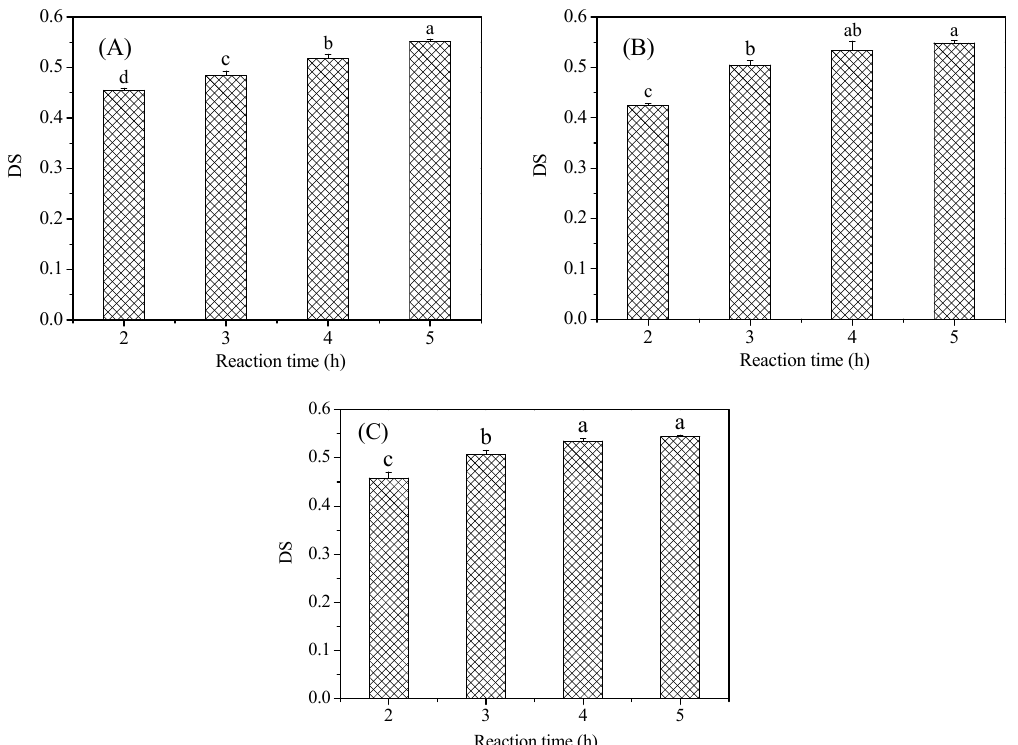
Figure 1. DS (degree of substitution) of malate starch samples: ( A ) Corn starch, ( B ) Potato starch, ( C ) Pea starch. Different letters in the same chart represent significant differences between different samples ( p < 0.05).